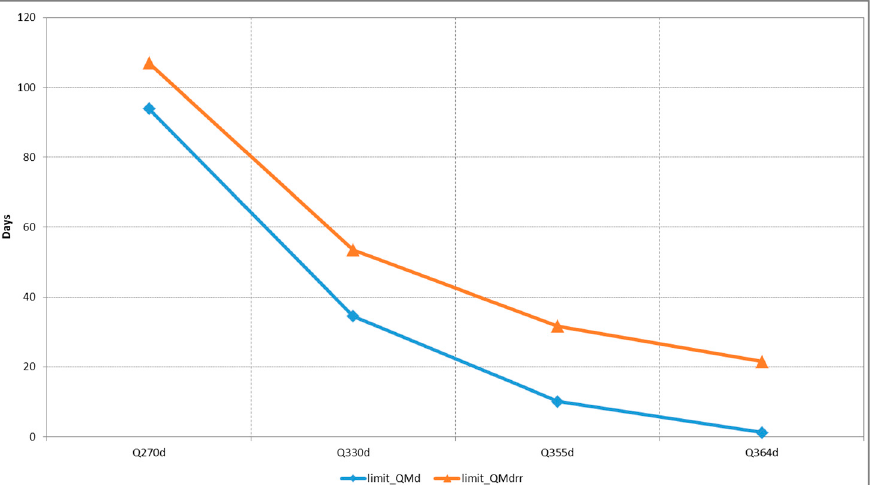
Figure 7. Average number of days with Q d < limit from 1961–2015 (comparison for limits Q Md and Q Md,rr ).